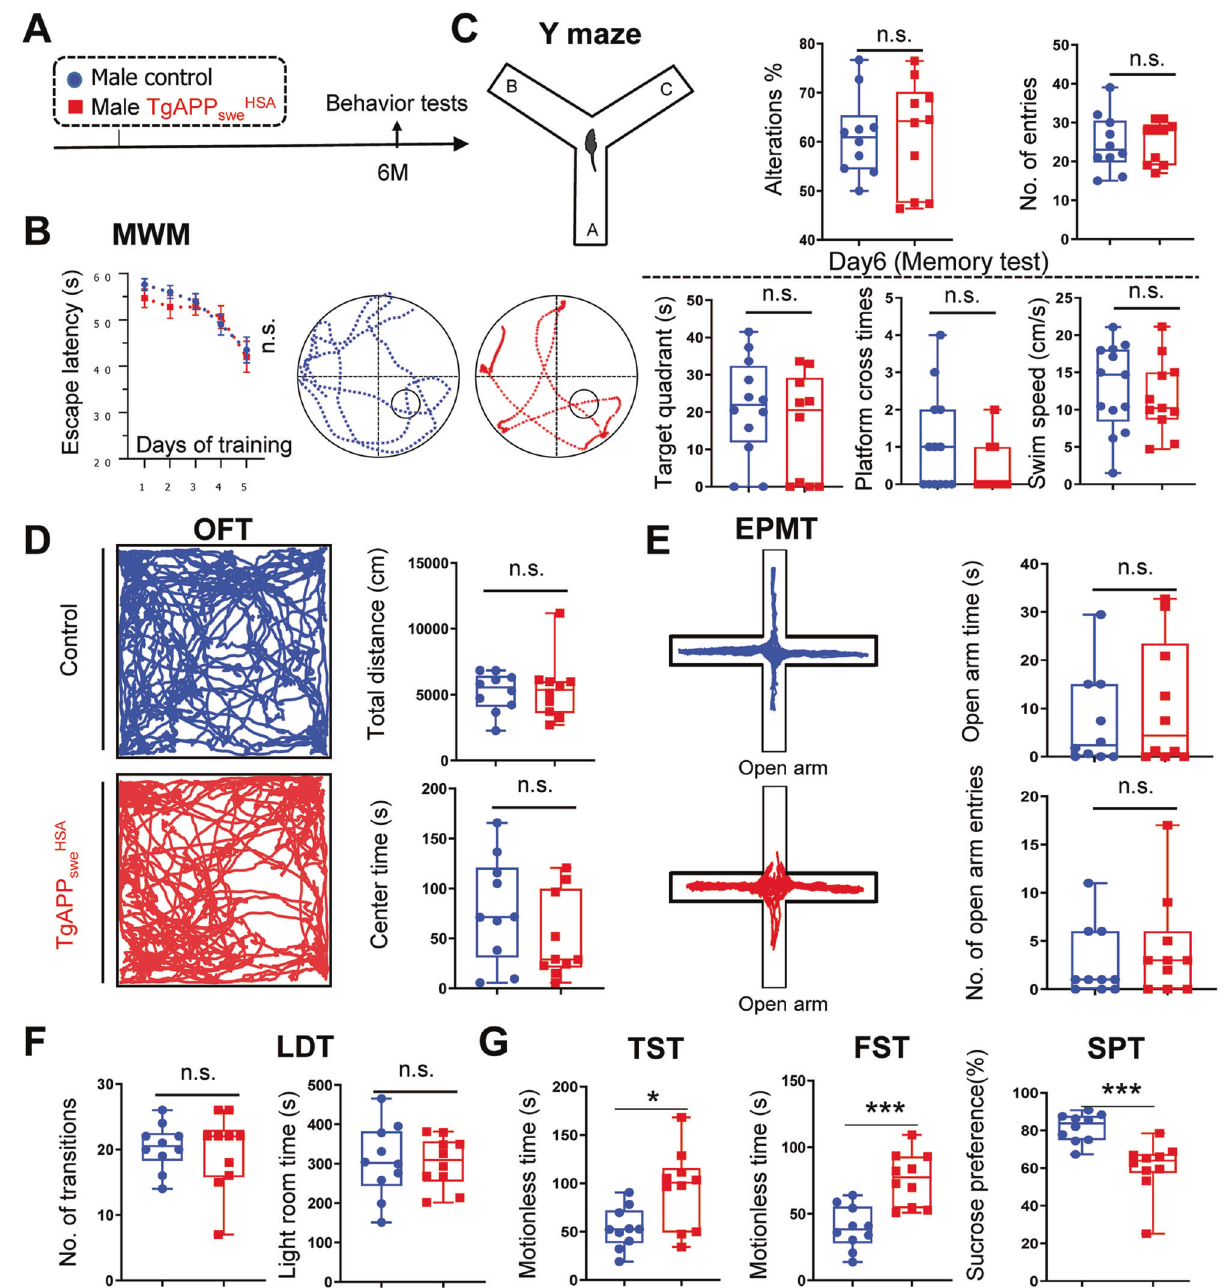
Fig. 4 Depression-like behaviors in 6-MO TgAPP sweHSA mice. A Schematic diagram of behavior tests. B MWM test: the latencies to reach the hidden platform during the training period, and the representative tracing images and quanti fi cation of time spent in target quadrant, platform crossing time, and swim speed in Day 6 memory test. C Y maze test: quanti fi ed alterations and number of total entries. D OFT: Representative tracing images and quanti fi cations of the total distance traveled and the center duration time. E EPMT: Representative tracing images and quanti fi cations of the open arm duration time and entries. F LDT: Quanti fi cation of the time spent in the light room and the number of transitions into the light room. G Quanti fi ed data of TST, FST, and SPT. In all these behavior tests, 6-MO control ( LSL-APP swe ) and TgAPP sweHSA mice (males) were examined. All quanti fi cation data are shown as box and whiskers ( n = 10 mice). * p < 0.05, ** p < 0.01, *** p < 0.001, student ’ s t test and correction of multiple comparisons using Holm-Sidak method was applied in depression-related behaviors, α set as 0.05, adjusted P values were both IL6 and IL1 β cytokines were increased in TgAPP sweHSA and Tg2576 serum samples (Fig. 5G); and PDGF-BB was signi fi cant lower in the serum samples of 6-MO TgAPP sweHSA and Tg2576 mice compared to those of control mice (Fig. 5H), but not in 3-MO TgAPP sweHSA mice (Fig. 5H). Together, these results reveal a similar, but not identical, pro fi le change in TgAPP swe HSA serum samples to